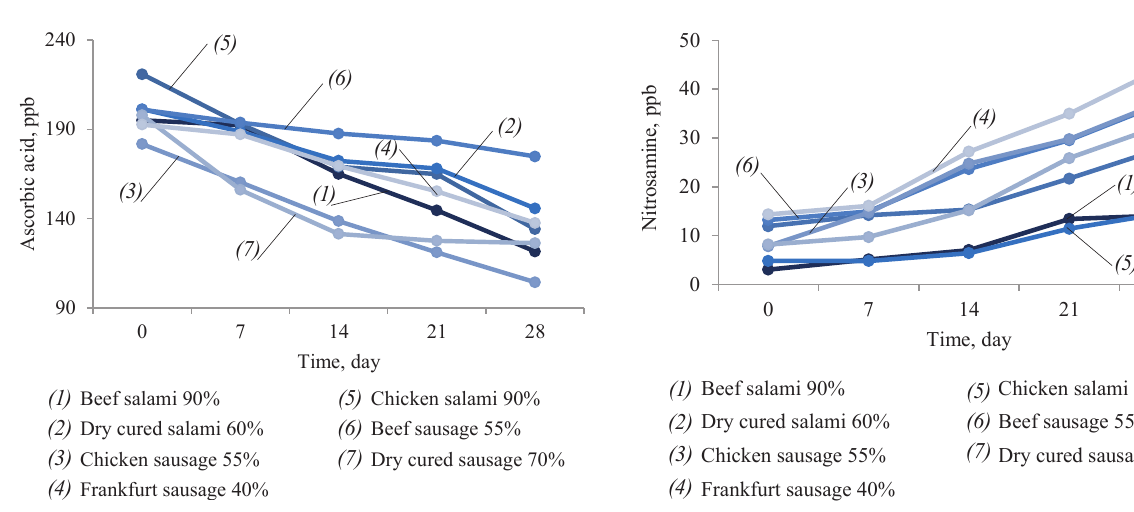
Figure 2 Ascorbic acid content (ng/kg meat) in sausages with different meat content from factory B on days 0, 7, 14, 21, and 28